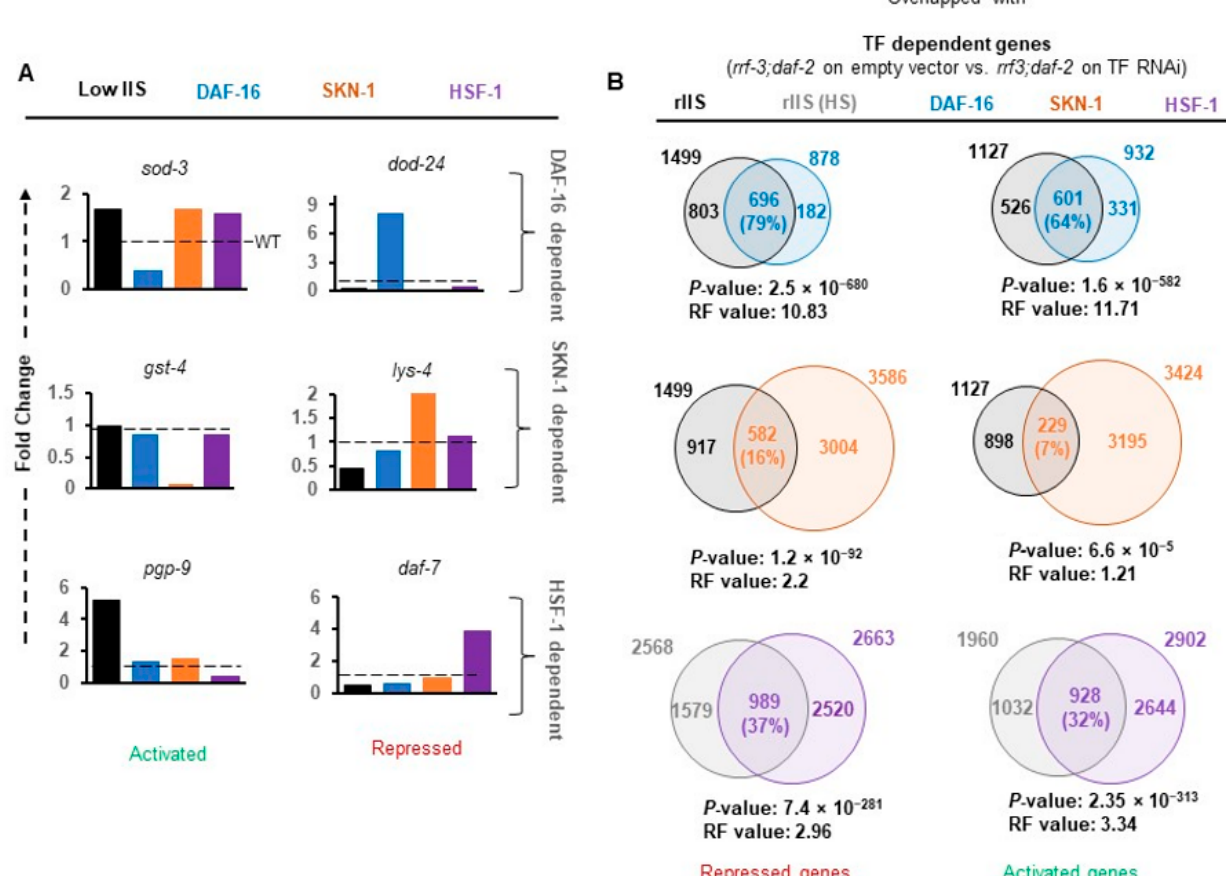
Figure 2. The major proportion of genes under reduced insulin signaling is controlled by DAF-16. ( A ) RNA expression of TFs’ well-established targets. Expression of the genes sod-3, gst-4, and pgp-9 activated by DAF-16, SKN-1, and HSF-1. lys-4, and daf-7 repressed by DAF-16, SKN-1, and HSF-1, respectively, increased without their regulators. ( B ) Venn diagrams represent the number of genes regulated by TFs, specifically under reduced insulin signaling. Major fractions of rIIS-dependent activated ( N = 601, 64%,) or repressed ( N = 696, 79%) genes are controlled by DAF-16, followed by HSF-1 (928, 32%) and (989, 37%). Contrarily, a small fraction of SKN-1-regulated genes were either activated ( N = 229, 7%) or repressed ( N = 582, 16%). Genes selected with p ≤ 0.05 and fold change ≥ 1.5. P: Hypergeometric p -value, HS: heat-shock, RF: representation factor, FC: fold change.